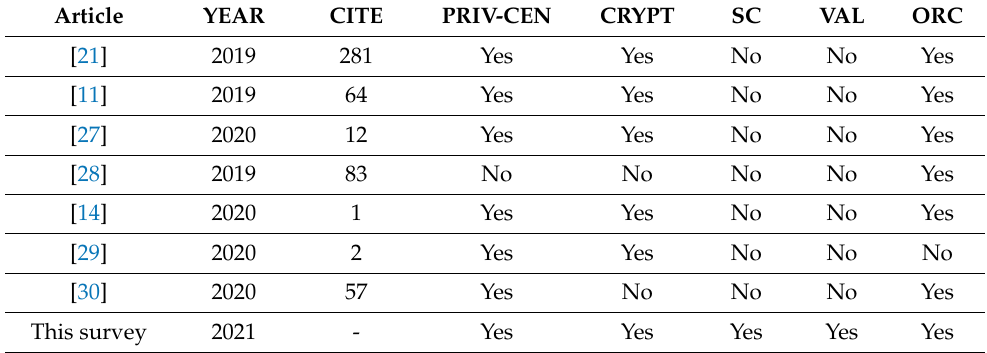
Table 1. A seven criteria comparison of various review articles on blockchain based privacy